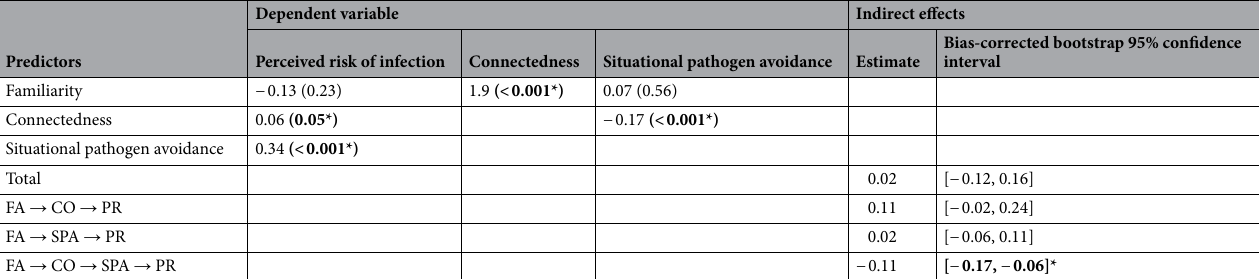
Table 3. Mediation analyses model 3. In study 2, two mediation models with two mediators (connectedness and disgust) were calculated. Mediation model 3 refers to the outcome variable perceived risk of infection. Table 3 shows the direct effects (β) in the mediation models and the indirect effects in mediation model 3. p-values less than 0.05 are assumed to be significant (*). An indirect effect is assumed as significant if the 95% CI does not include 0